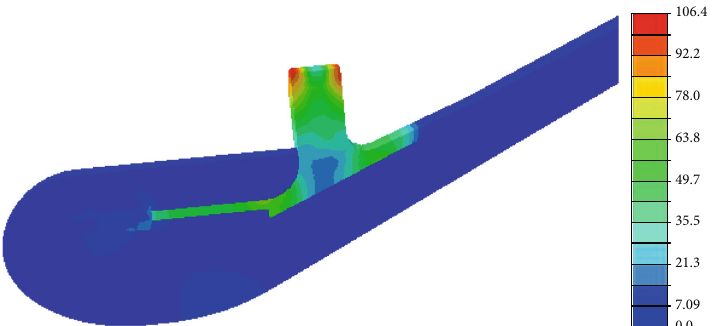
Figure 8: Von Mises stress distribution under the pressure at time 28s, MPa.